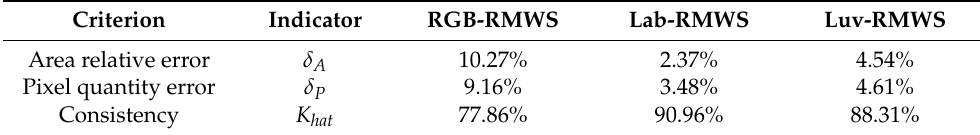
Table 5. Evaluation of the accuracy of the cultivated land extraction from the experimental images.